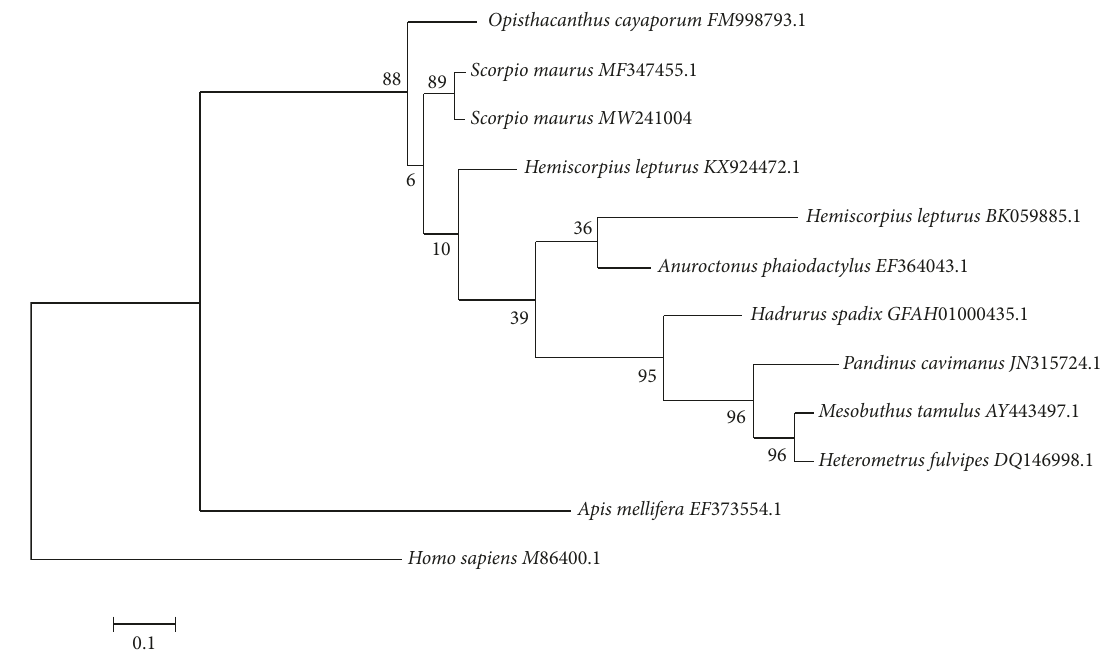
Figure 3: Phylogenetic relationship between different species of scorpions, Apis mellifera , and Homo sapiens based on PLA sequences. The accession number of each sequence has been shown in front of its name. The percentage of replicate trees in which the related taxa clustered together in the bootstrap test (1000 replicates) has been displayed next to the branches. The scale bar corresponds to 0.1 substitutions per